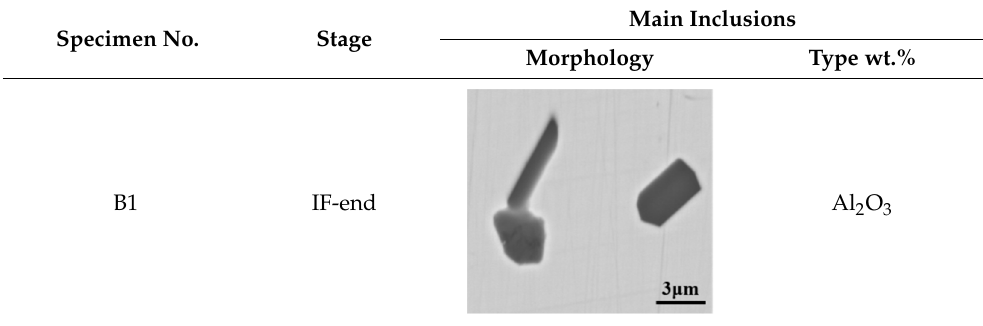
Table 5. Morphology and composition (in mass %) of typical inclusions at different stages (Speci- men B1–B8). Main Inclusions Stage Morphology Type wt.%